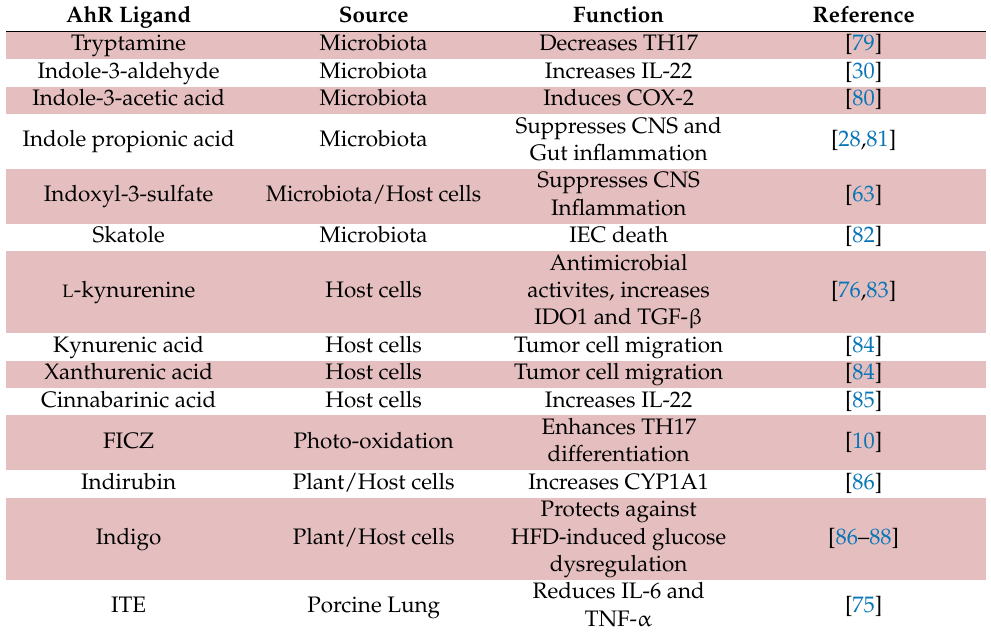
Table 1. AhR Endogenous